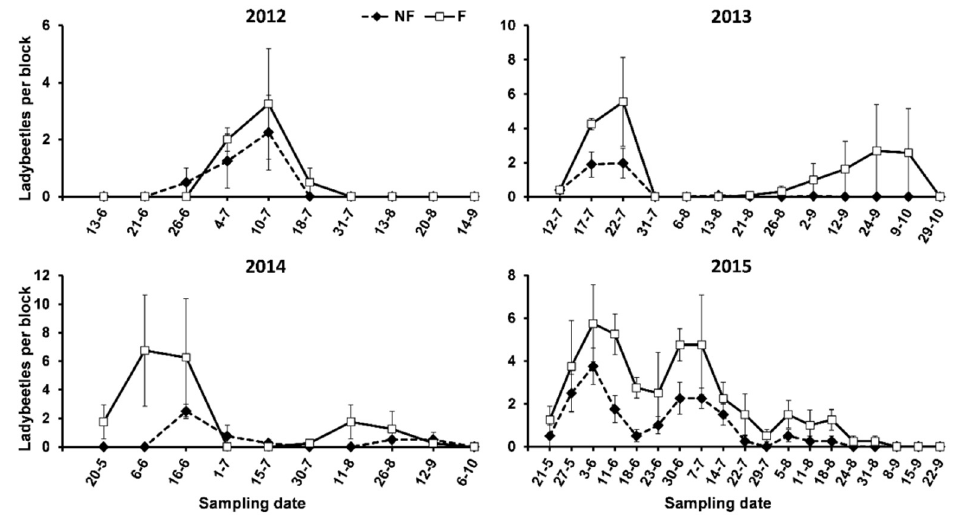
Figure 3. Abundance of ladybeetles in oleanders surrounded (F) and not surrounded (NF) by service plants in the study period.